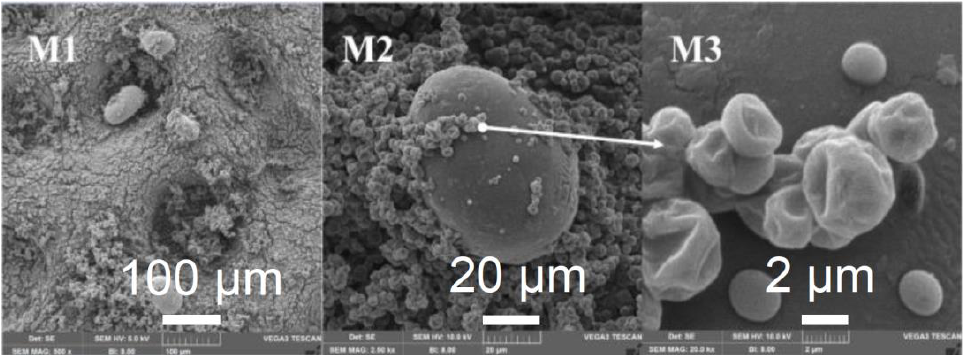
Figure 3. Scanning electron photomicrographs of the powders formed in the spray drying of the mixture of maltodextrin (2.5% w / v ); gum arabic (2.5% w / v ); soluble starch (5.0% w / v ) with enzymatic extract ( M1 – M3 ). The white arrows indicate the point where the magnification was performed (20 kx).